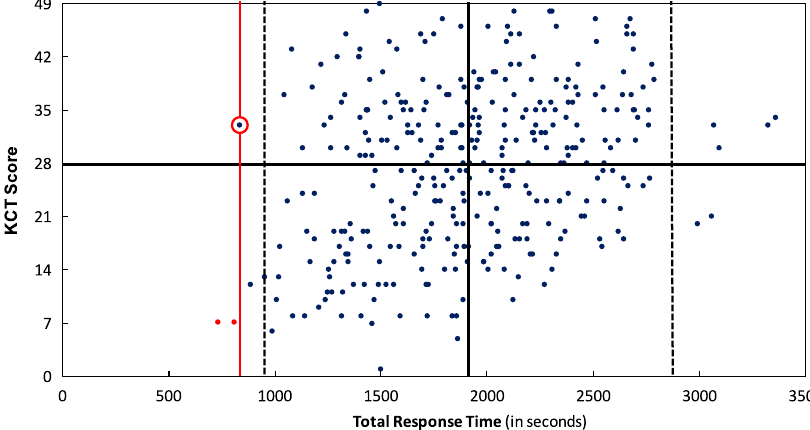
FIG. 2. Scatter plot of the KCT score versus the time needed to complete the test. The solid black lines indicate the mean values, the dashed lines show the 2 σ interval (2 standard deviations) for the response time. A time greater than 830 sec was necessary to score higher than the mean (see data point marked with a circle). This time was determined as the minimal time needed to take the test seriously. Data points with a response time shorter than 830 sec (marked red) were removed from the sample.